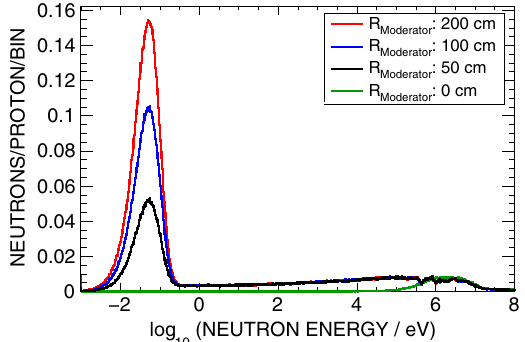
FIG. 8. Neutron position along the ion beam for different moderators, the small version of the tungsten target and 800-MeV protons. The x-axis has a bin width of 1 cm.